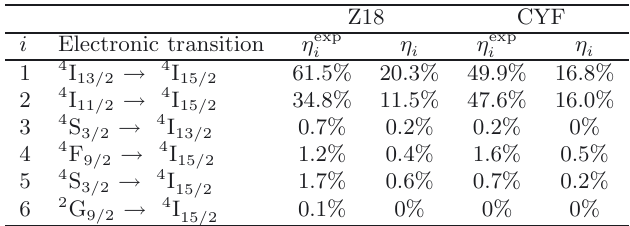
Table 2. Er 3+ Electronic transitions observed in emission, η exp i